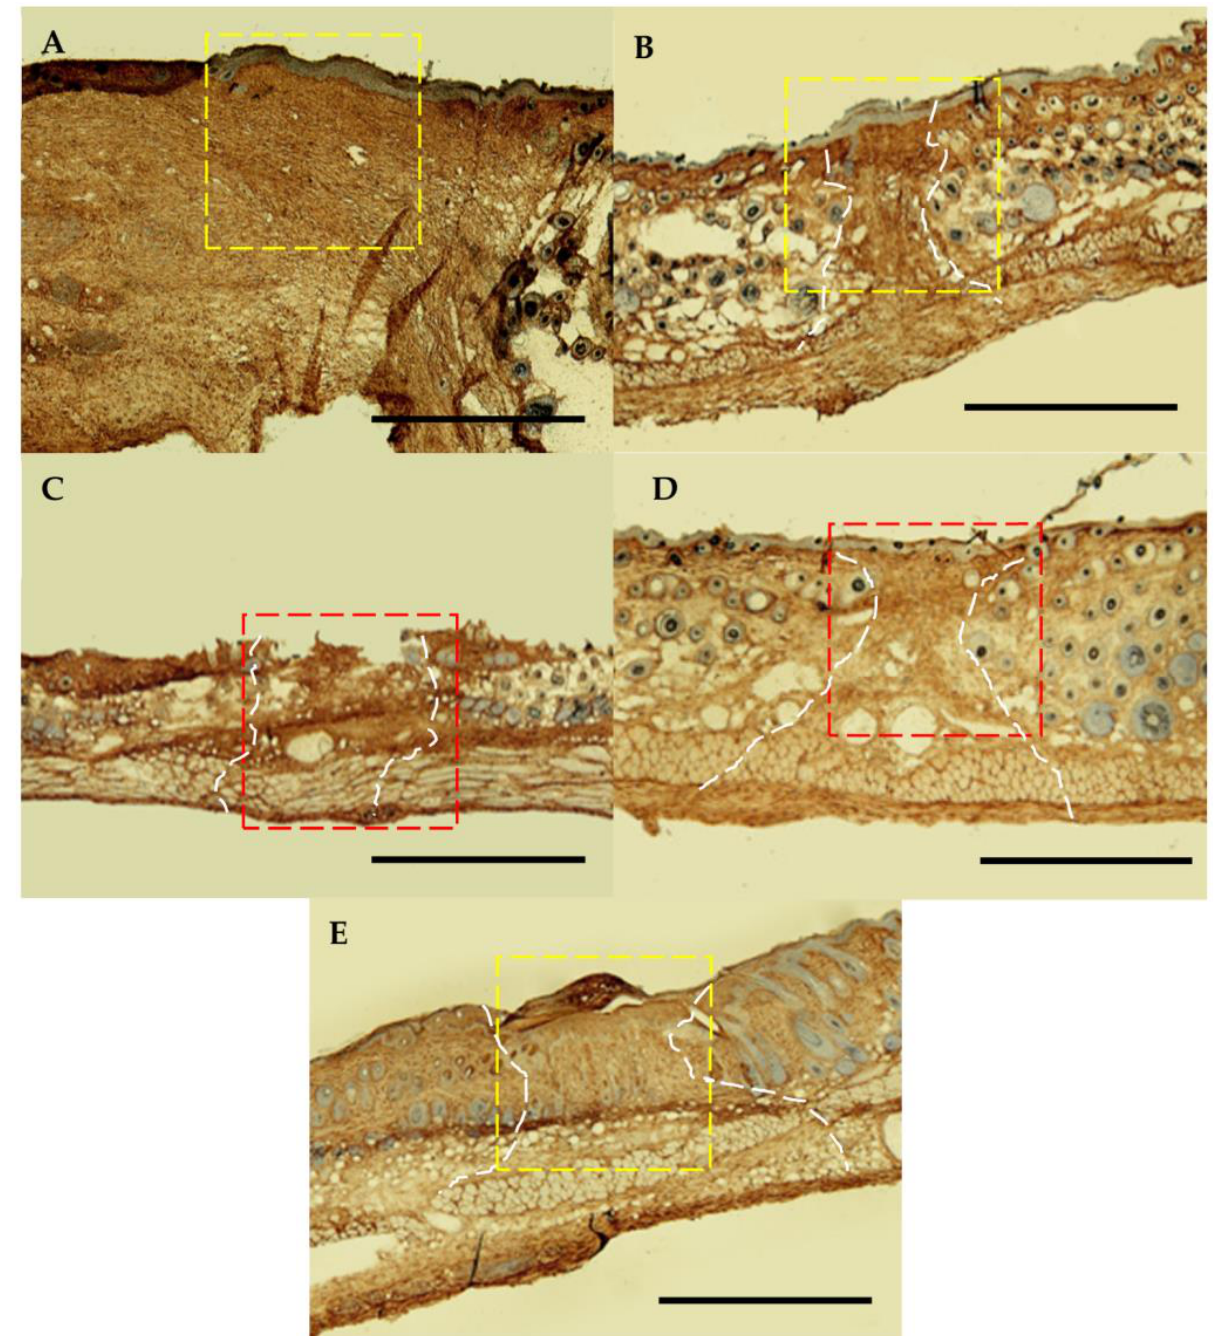
Figure 11. Representative keratin-6 histological staining images of the harvested tissue at day 14 of control ( A ), PEG-D4-Si ( B ), PEG-D6-Si ( C ), PEG-D8-Si ( D ), and PEG-D6 ( E ). Red and yellow dash lines indicate the area used to calculate keratinocyte content. White dash line indicates the wound proximities. Scale bars are 1 cm.